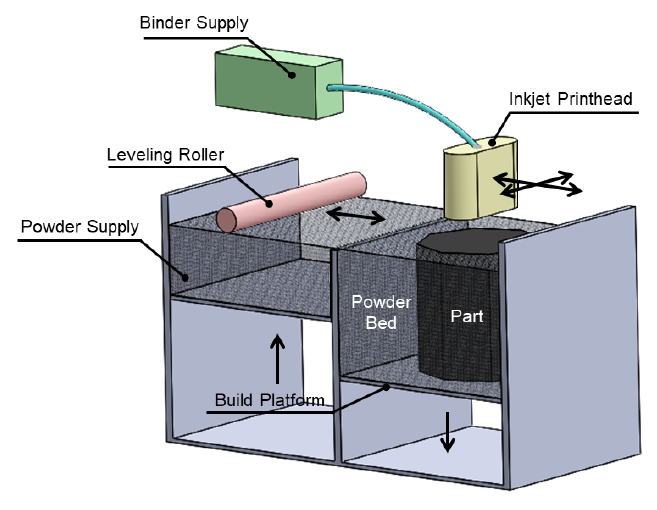
Figure 4. Material Jetting (MJ).